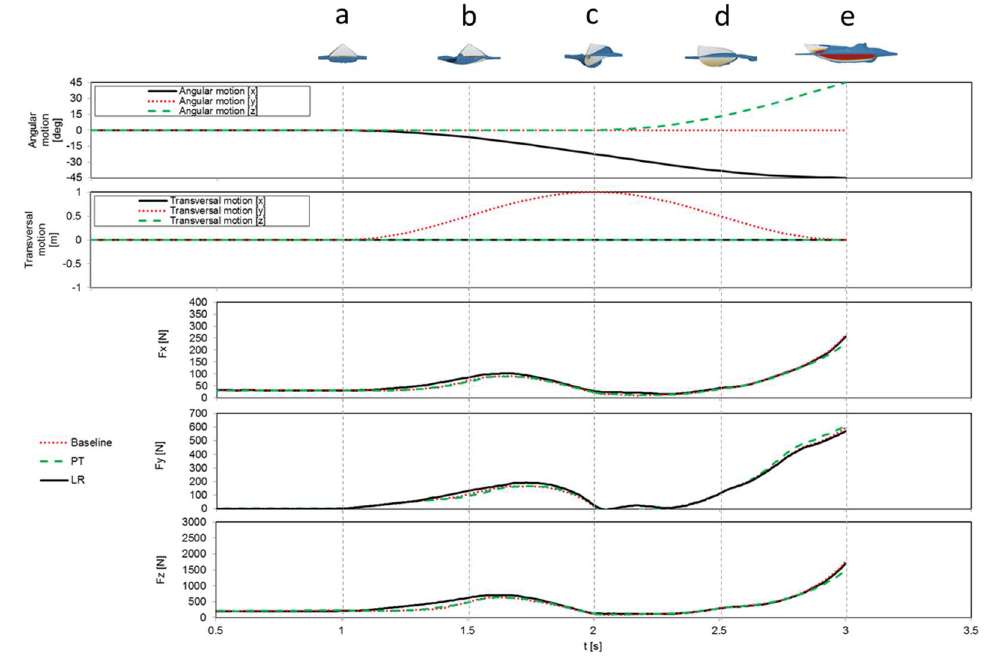
Figure 6. Forces from the maneuvering